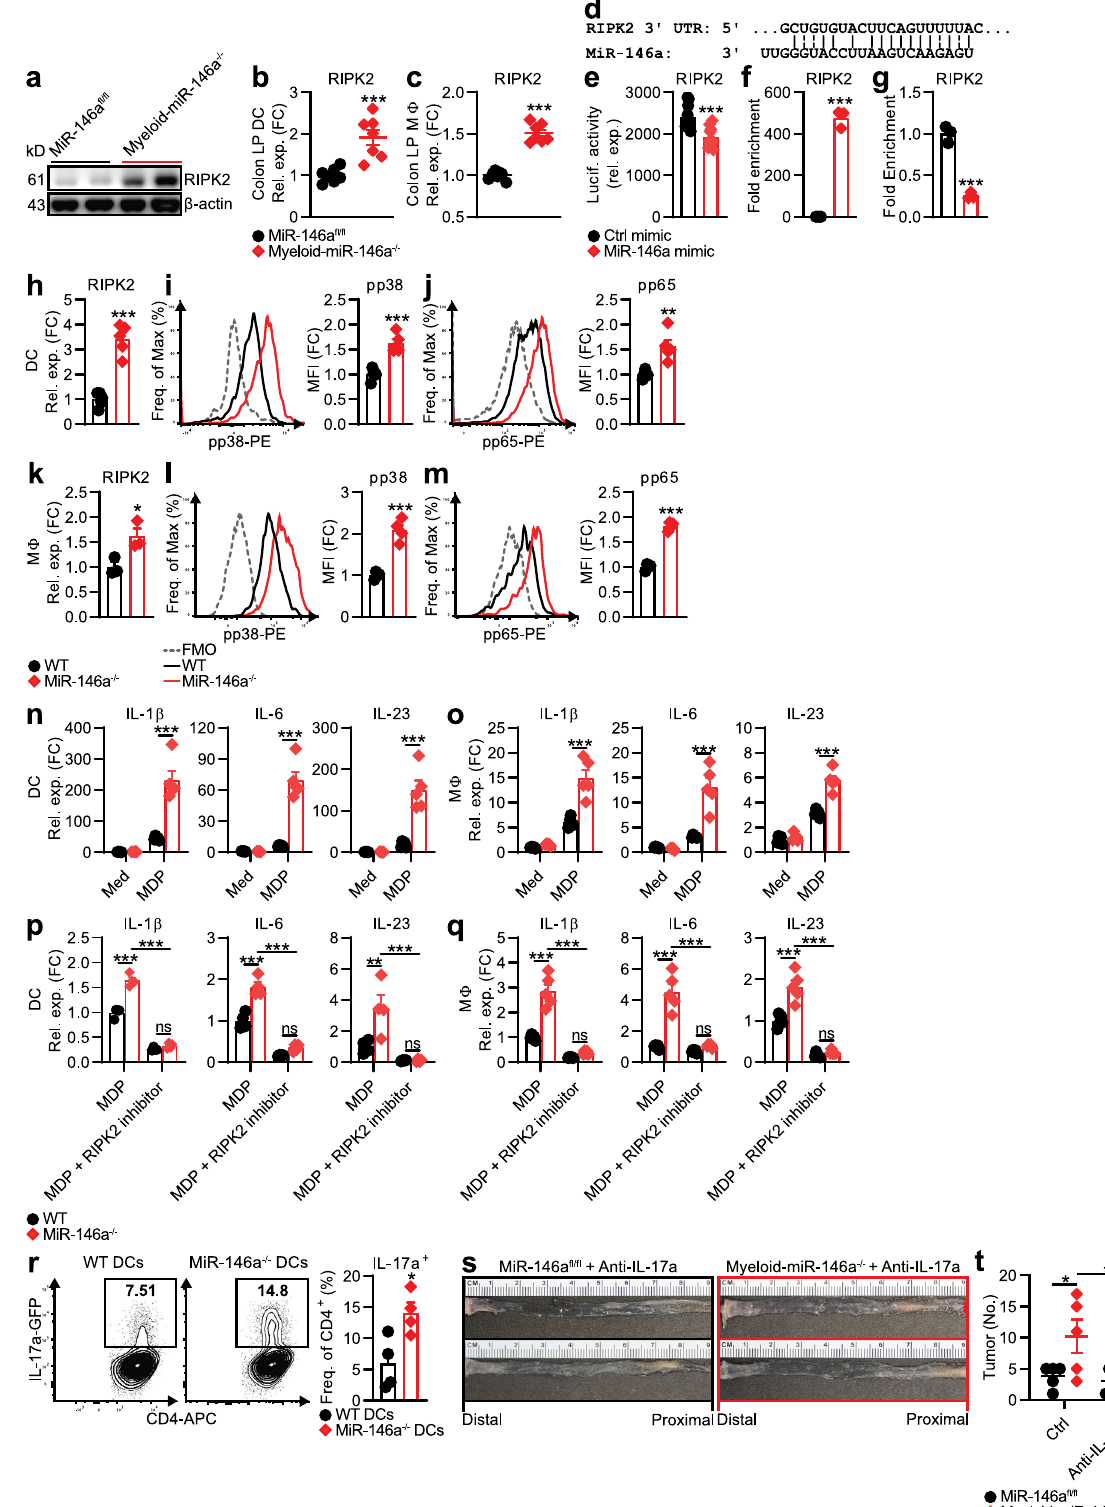
initial signaling intermediate necessary for IL-17-induced activation of NF- κ B and MAPKs 43 (Fig. 4d). Accordingly, we also found an increased activation of NF- κ B [phospho-p65 (pp65)] and MAPKs family member, pp38, in CRC tissues from miR-146a − / − mice (Fig. 4d). A similar increase in IL-17R signaling was also detected in